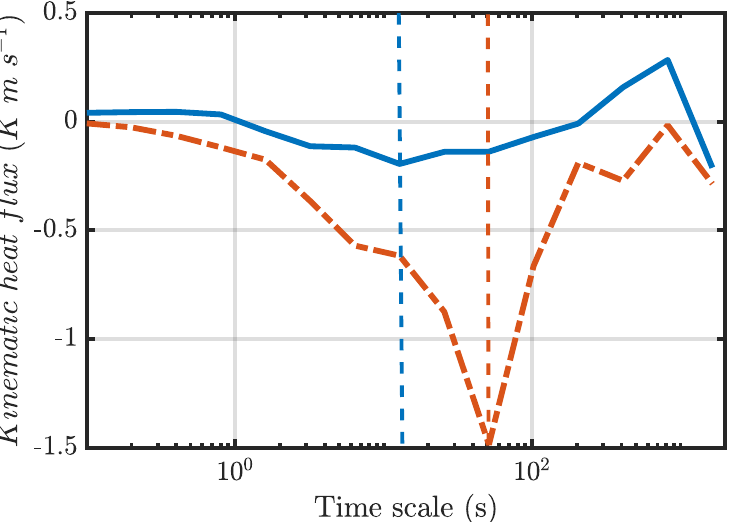
Figure 7. Kinematic heat flux multiresolution decomposition for branch 1 of SL2. The blue line and red dashed line correspond to the periods before ( ≈ 3 h) and during ( ≈ 30 min) the presence of branch 1 of SL, respectively, above T0k, during the early hours of 21 April 2014. The vertical blue and red dashed lines indicate, respectively, the wT -cospectral peaks before and during the SL2 displacement above the site.